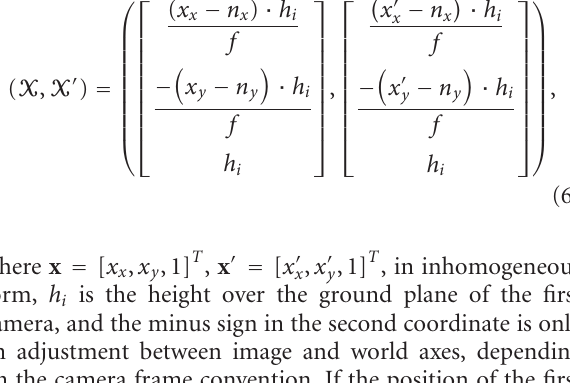
(only relative pose must be determined here), the coordinates of X are the correct coordinates of the projection of x in the ground plane, in actual metric units. But X (cid:3) is not the correct projection because the second camera position was not considered—there is a di ff erence of translation and scale between the two sets of corresponding X (cid:3) and X points in the ground